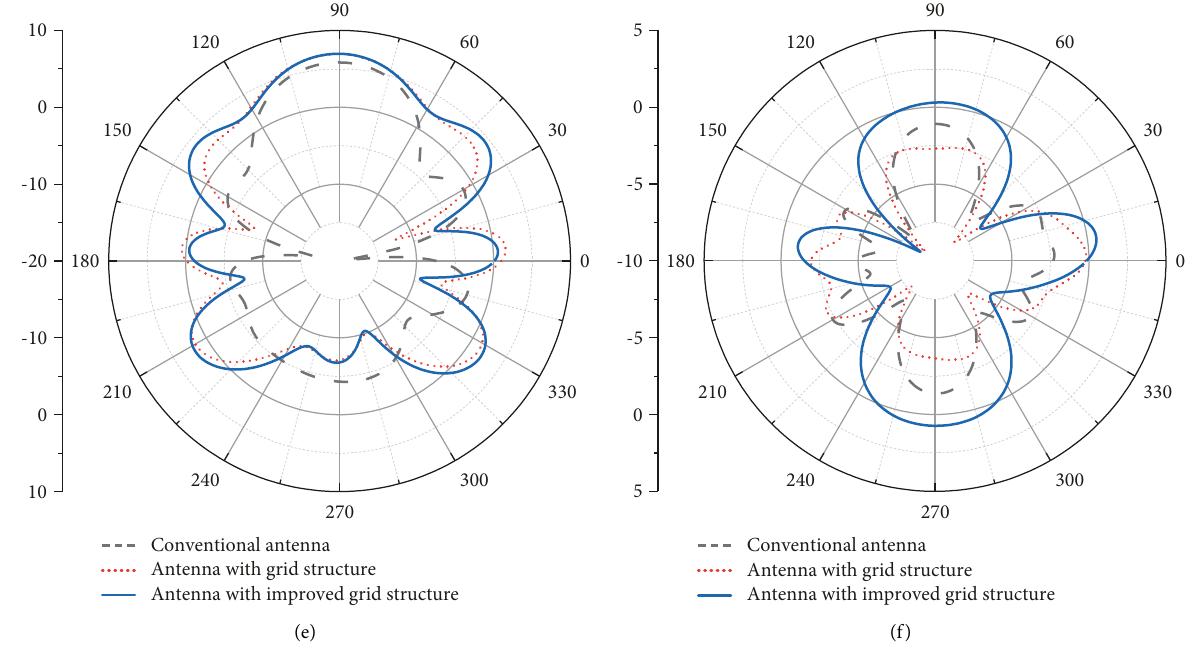
Figure 5: Antenna electric field radiation patterns: (a) y - z plane radiation patterns at 5GHz; (b) x - y plane radiation patterns at 5GHz; (c) y - z plane radiation patterns at 5.8GHz; (d) x - y plane radiation patterns at 5.8GHz; (e) y - z plane radiation patterns at 6GHz; (f) x - y plane radiation patterns at 6GHz.